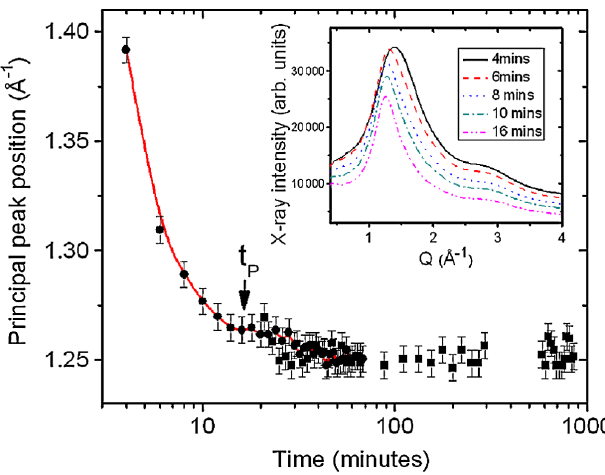
FIG. 3. The background corrected x-ray diffraction patterns for six amorphous gels formed from supersaturated solutions mea- sured in situ using the acoustic levitator. These x-ray spectra were taken after 14 min of levitation for Clotrimazole, after 20 min for Probucol, after 16 min for Ibuprofen, after 10 min for Dibucaine, after 16 min for Ketoprofen, and after 21 min for Clofoctol. The broken lines represent the x-ray diffraction pat- tern of the pure solvents used (see text): ethanol (dashed line) and acetone